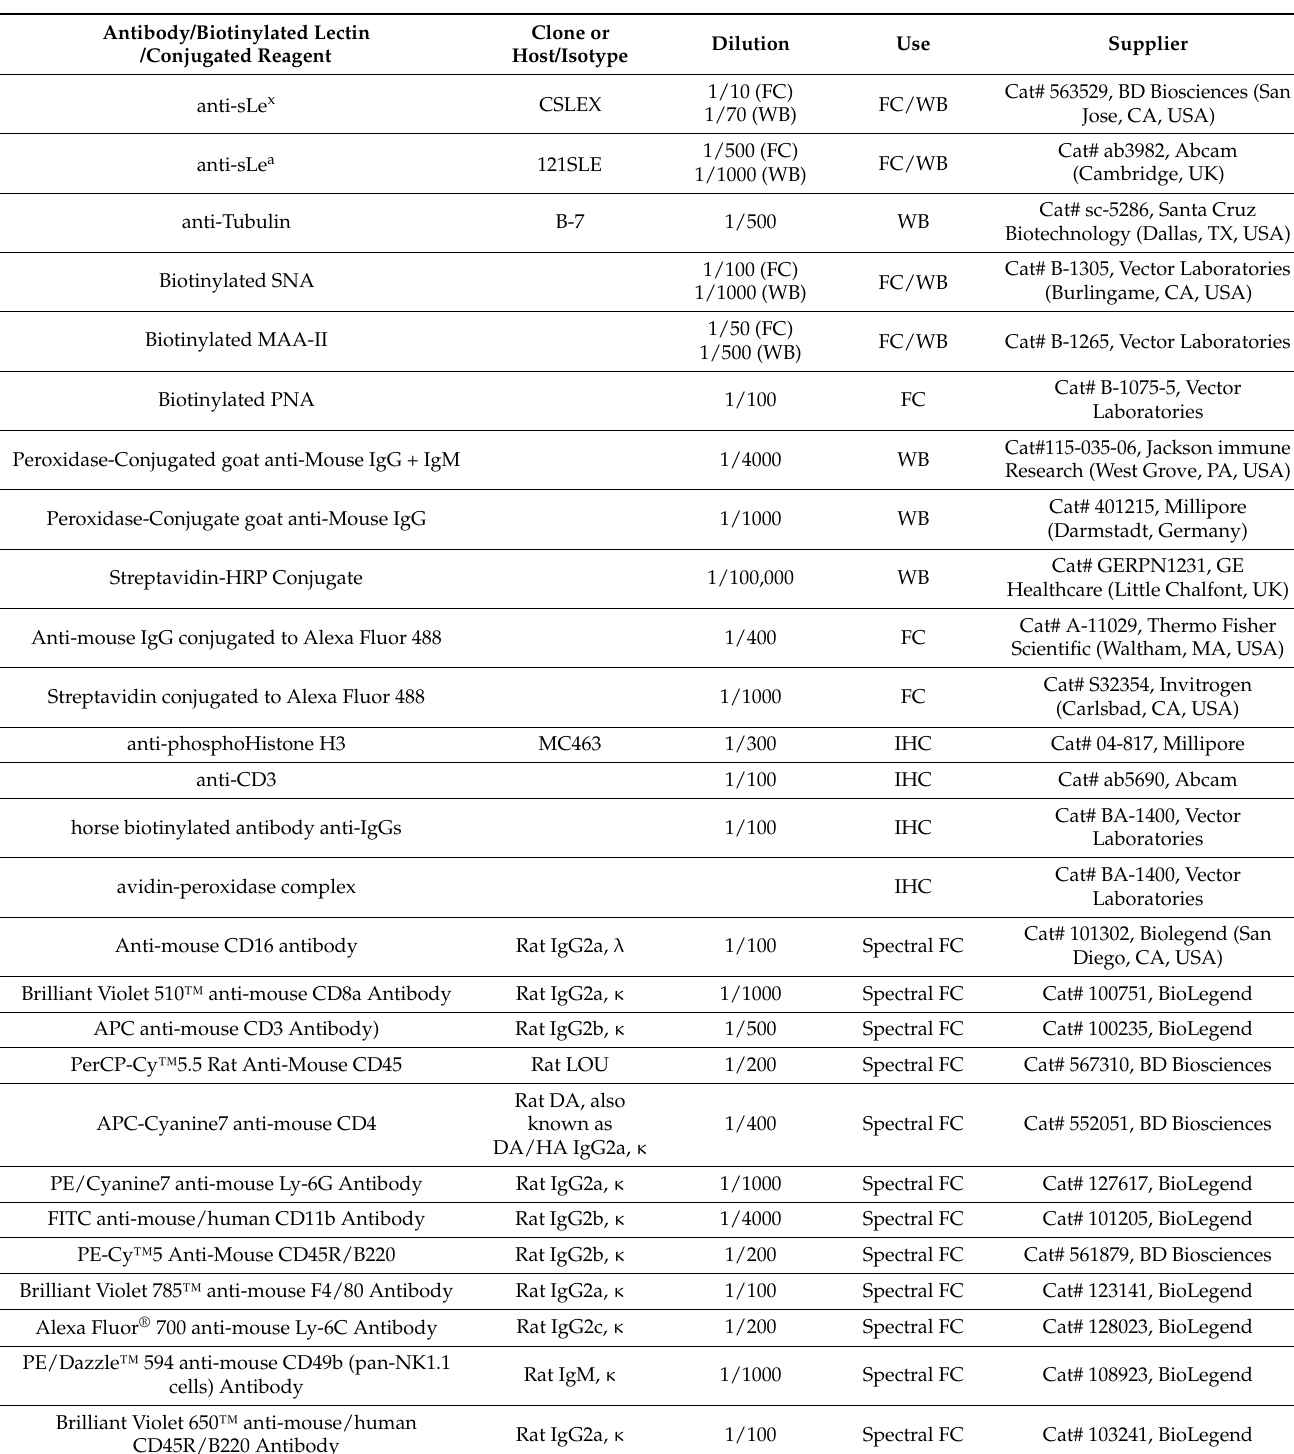
Table 1. Lectins and antibodies for Flow cytometry (FC), spectral FC, WB, and IHC. Antibody/Biotinylated Lectin Clone or Dilution /Conjugated Reagent Host/Isotype